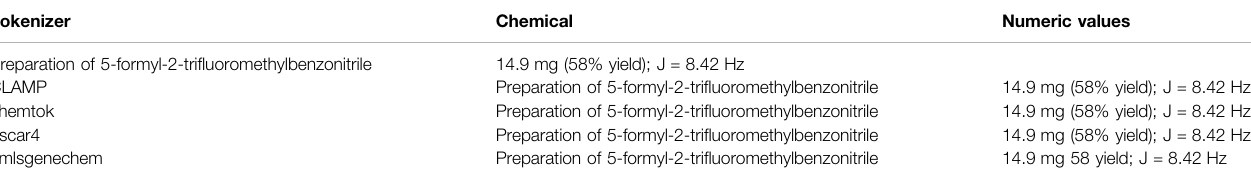
TABLE 7 | Tokenization outputs of four tokenizers: CLAMP, chemtok, oscar4, and umlsgenechem.